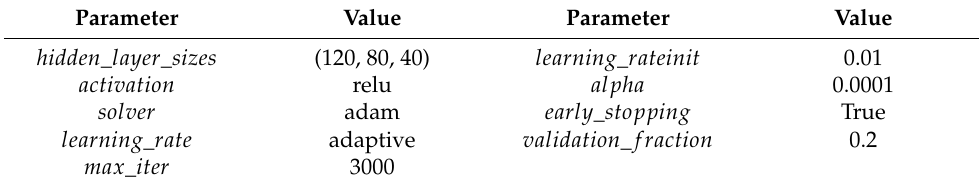
Table 2. Artificial Neural Network hyperparameters.